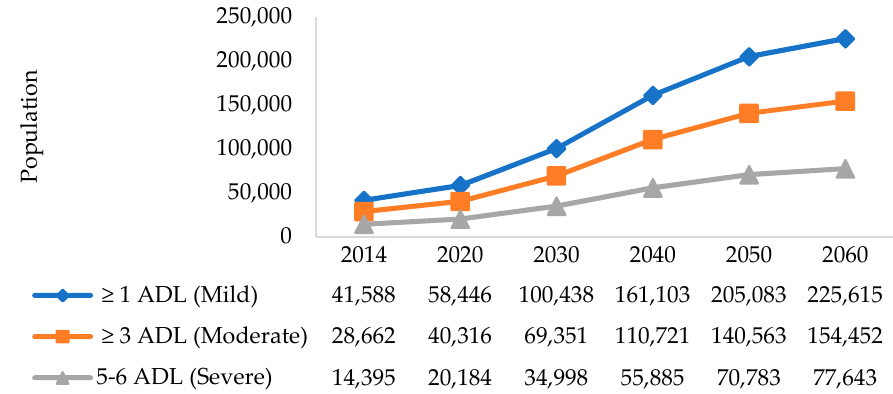
173 Figure A. 40-year Projected Disability Prevalence (Mild, Moderate, Severe) till 2060 in Singapore